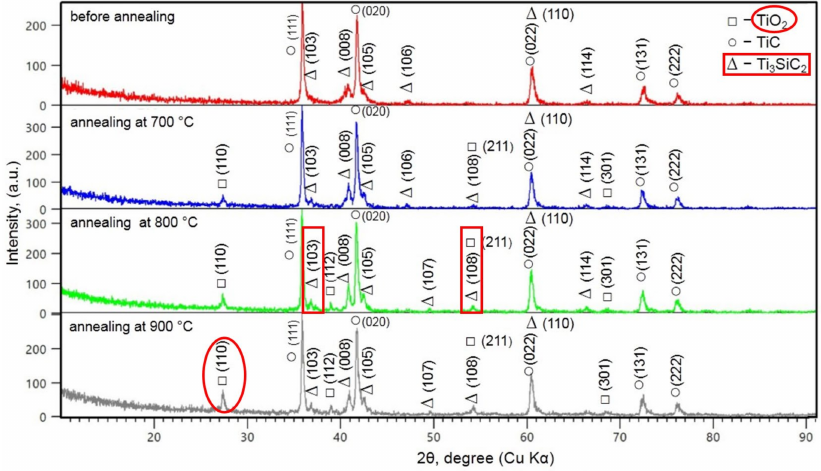
Figure 9. Diffractograms of Ti–Si–C coatings at different annealing temperatures. After annealing, the formation of TiO 2 phases and an increase in the reflex intensities (103) and (108) of Ti 3 SiC 2 phases were observed. Compared to the after-sprayed coatings, the phase fraction of the Ti 3 SiC 2 phase in the after-annealing coatings increased signifi- cantly. A change in the fraction of phases indicated a solid-phase transformation during thermal activation. An increase in the TiO 2 line intensity was observed after annealing